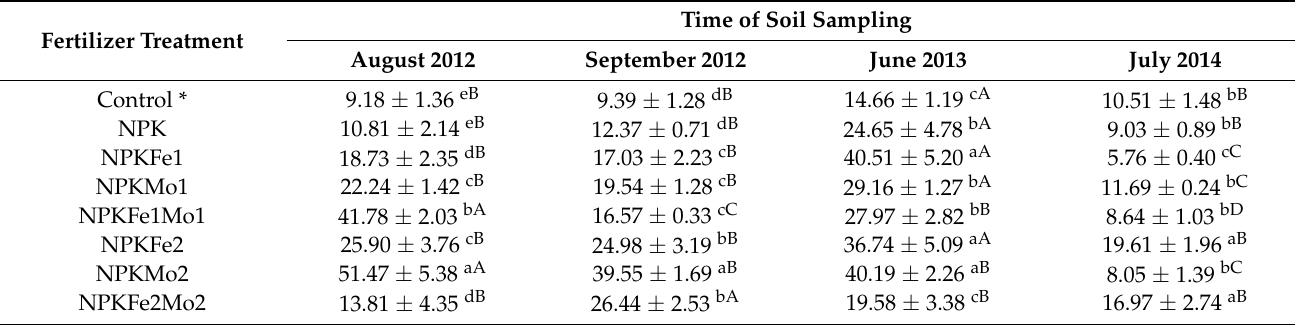
Table 3. Nitrogenase activity in soil incubated with C 2 H 2 for 24 h (in nM C 2 H 4 ). Fertilizer Treatment